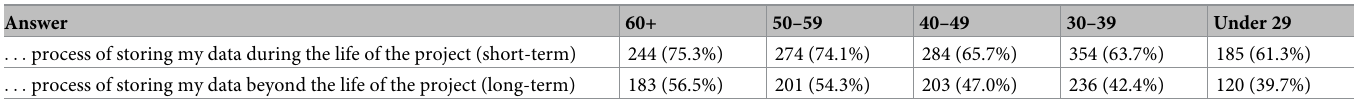
Table 3. “The following statements relate to how you store and manage your data. Tell us how much you agree with the following ways to complete the sentence: I am satisfied with ...